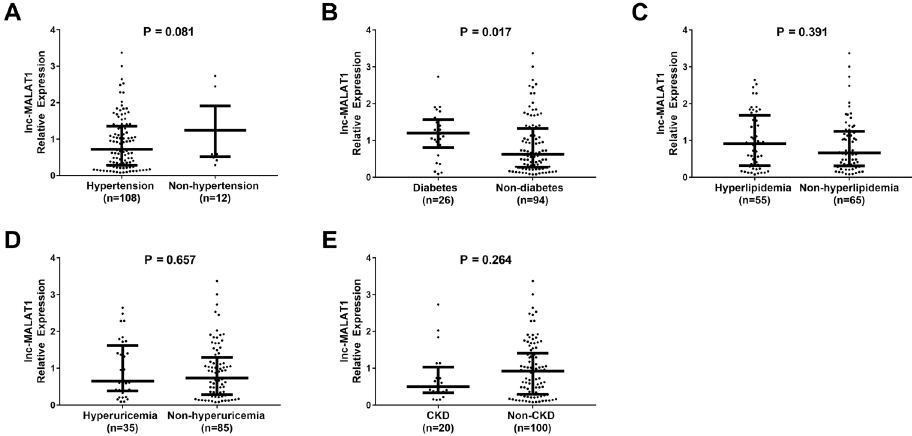
Figure 4. lnc-MALAT1 expression in acute ischemic stroke patients with different risk factors: hypertension and non-hypertension patients ( A ), diabetes and non-diabetes patients ( B ), hyperlipidemia and non-hyperlipidemia patients ( C ), hyperuricemia and non-hyperuricemia patients ( D ), as well as chronic kidney disease (CKD) and non-CKD patients ( E ). Horizontal lines indi- cate means ± SD (Wilcoxon rank sum test). lnc-MALAT1: long non-coding RNA metastasis-associated lung adenocarcinoma transcript 1.